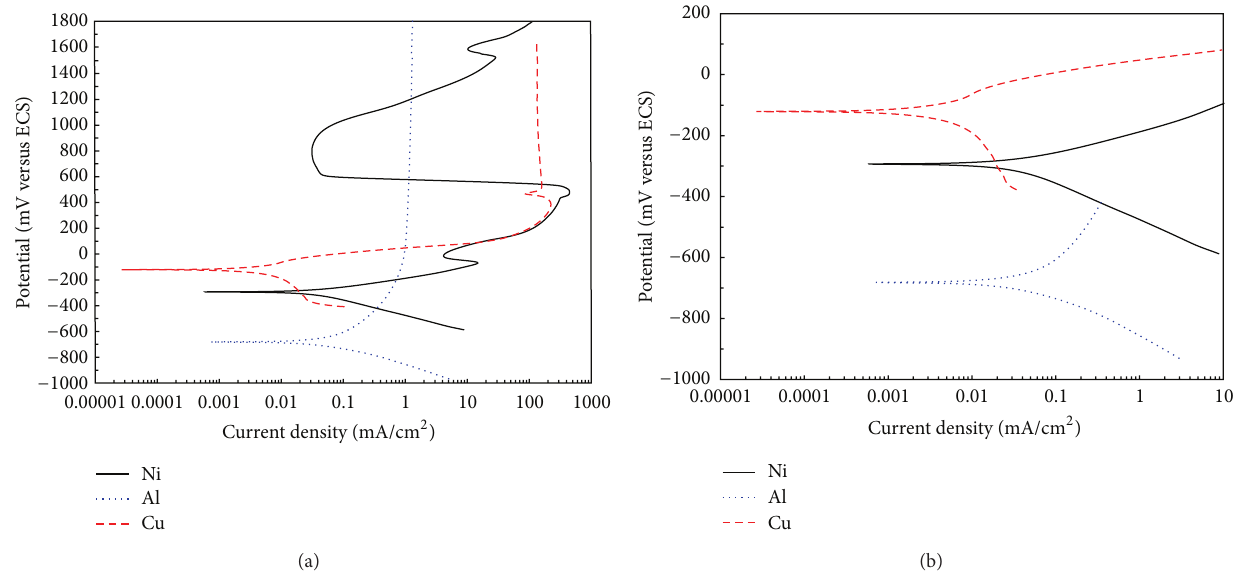
Figure 2: Polarization curves of Ni, Cu, and Al tested in a 1.0 M H 2 SO 4 solution at 25 ∘